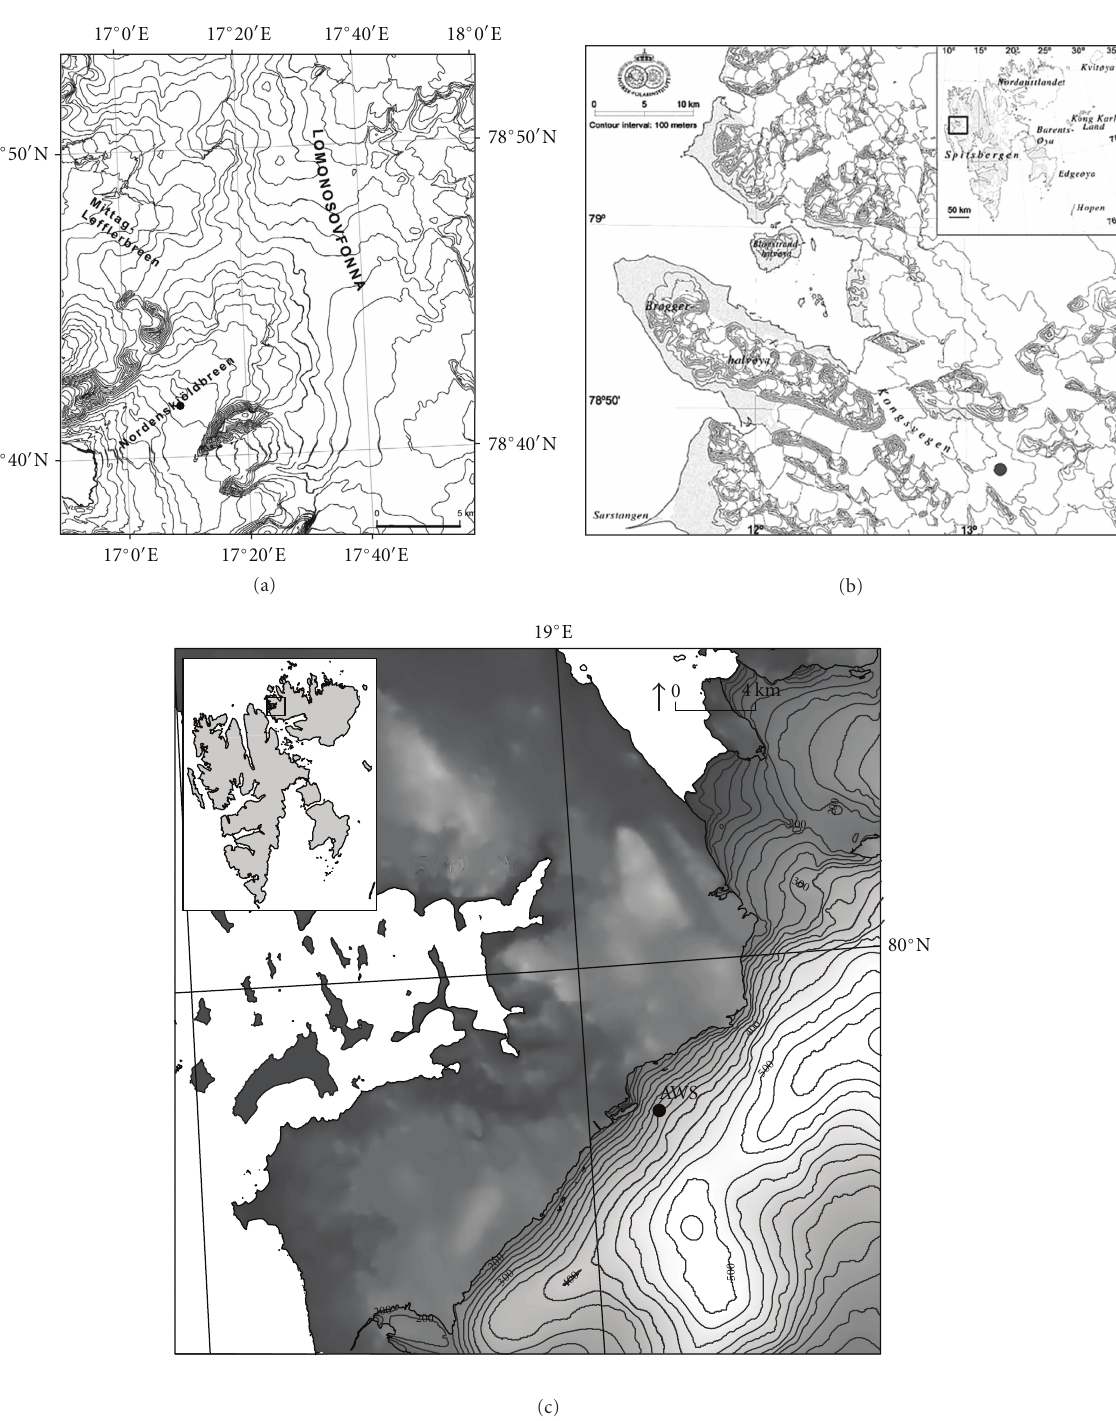
Figure 2: The AWS site of (a) Nordenski¨oldbreen with 50m contour lines (drawn by Richard Pettersson), (b) Kongsvegen with 100 m contour lines [62] (modified by Florian Karner), and (c) Vestfonna with 25 m contour lines (drawn by Rickard Pettersson). The DEM data are from Norwegian Polar Institute